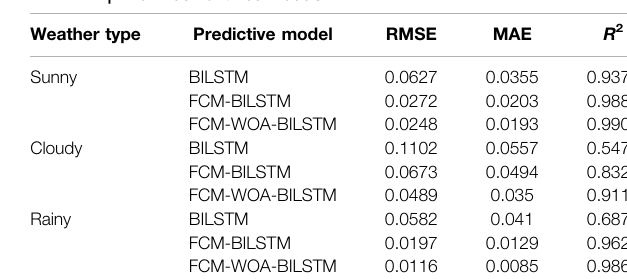
TABLE 1 | Error index of three